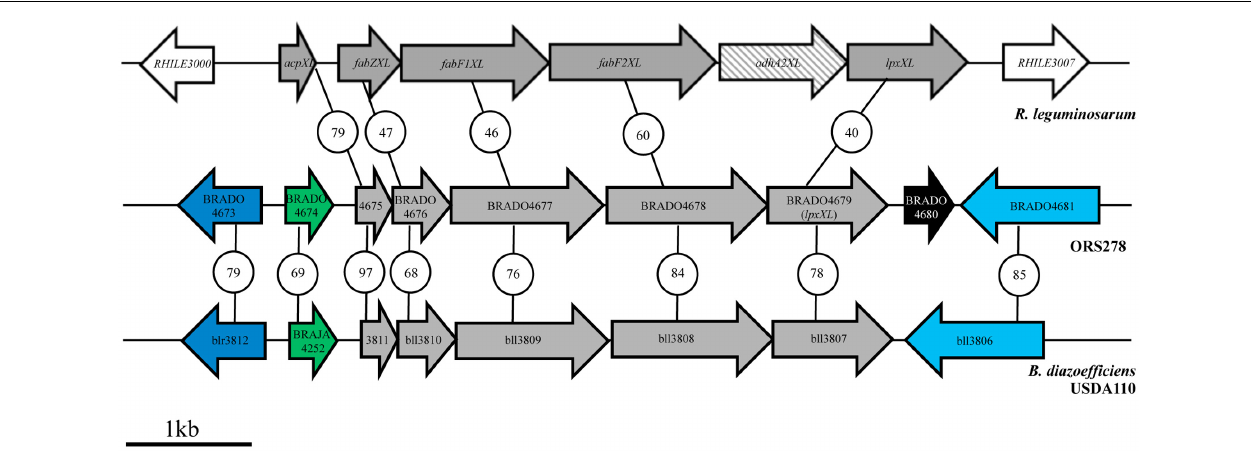
FIGURE 2 | Identification of a gene cluster putatively involved in VLCFA biosynthesis in Bradyrhizobium strains by comparative genomic analysis with R. leguminosarum . The values in the circles represent the percentage of identity between the corresponding proteins. Genes in gray have been shown to be involved in VLCFA biosynthesis and their transfer to the lipid A in R. leguminosarum . The CDS in black is specific to photosynthetic Bradyrhizobium strains. Homologous genes are indicated by the same color. The genes are named according to their annotation in the published genomes ( R. leguminosarum bv. viciae 3841, NC_008380; Bradyrhizobium sp. ORS 278, NC_009445.1; and B. diazoefficiens USDA110, NC_004463).